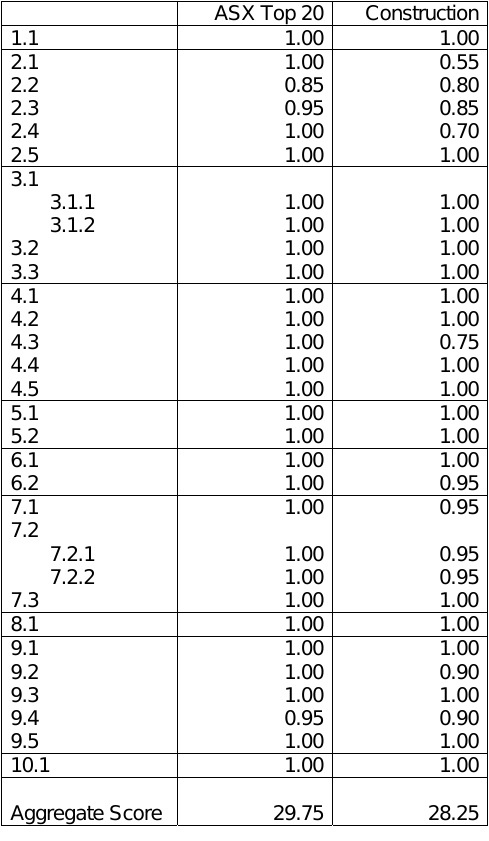
Table 3: Compliance with the ASX CGC